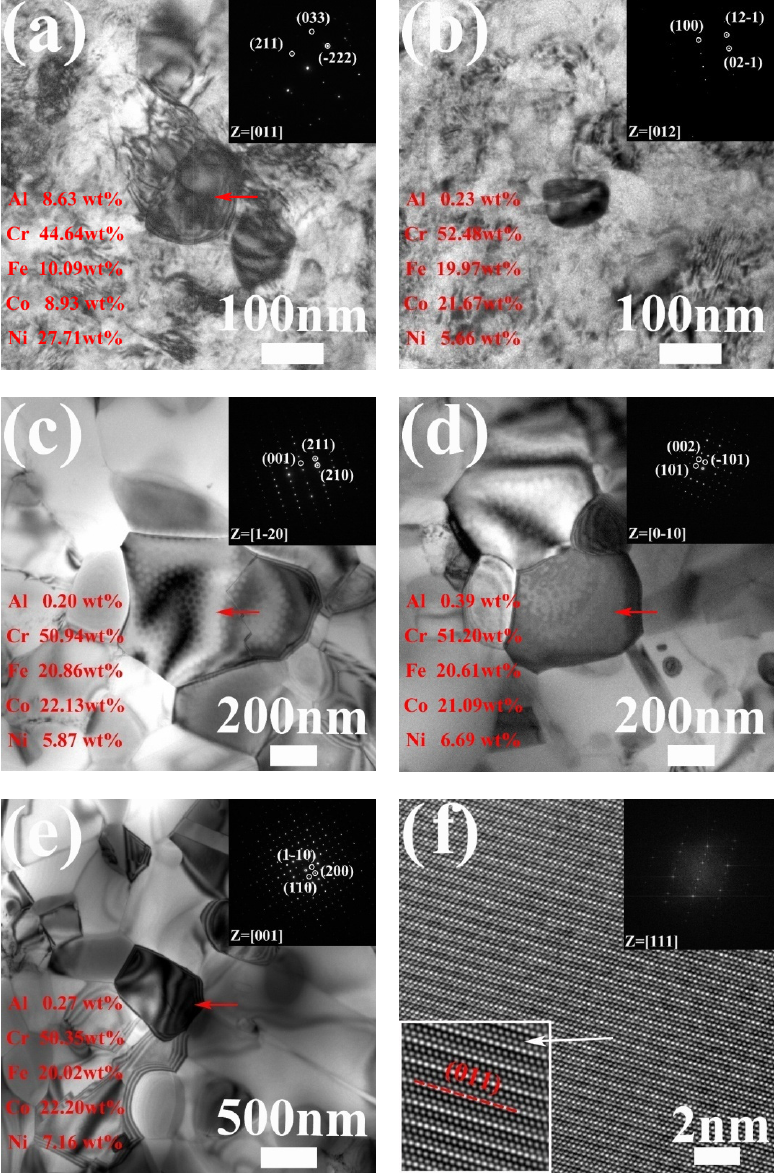
Figure 8. TEM images and corresponding SADP of σ phase in AR samples: ( a ) AR540 sample; ( b ) AR590 sample; ( c ) AH660 sample; ( d ) AR700 sample; ( e ) AR800 sample; ( f ) high-resolution scanning TEM image of σ in AR800.